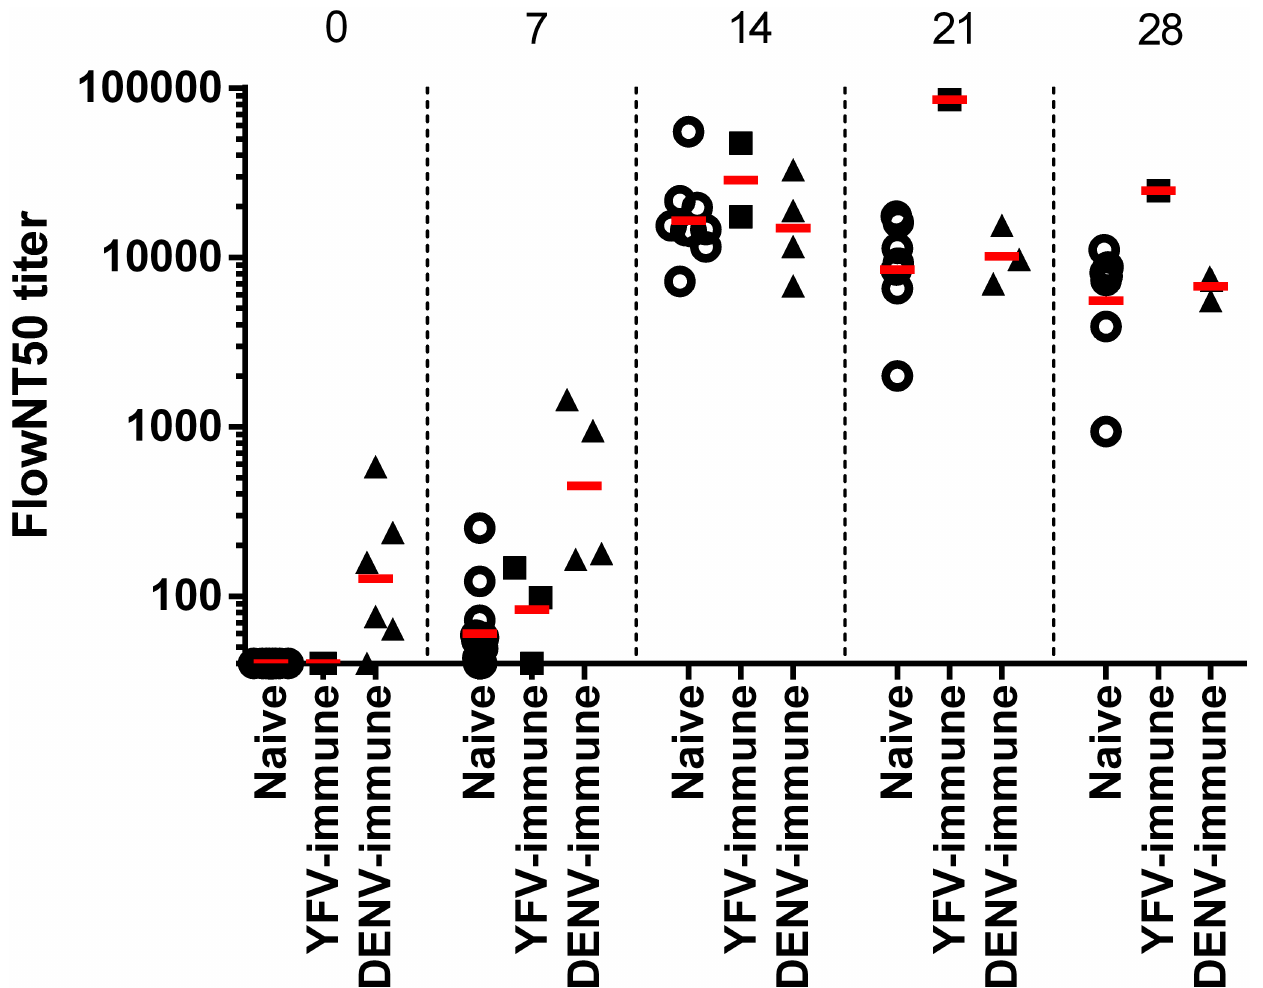
Fig 4. Kinetics of neutralizing antibody. Zika virus flow cytometry-based assay 50% neutralization (FlowNT50) titers were determined on days 0, 7, 14, 21, and 28 post-infection. The FlowNT50 titers for individualanimalswithin each group are shown with the geometric mean titer (GMT) indicatedwith a red bar. The respectivesample sizes (n) for na ï ve,YFV-immune, and DENV-immune groups were 14, 5, and 6 on day 0; 12, 3, and 4 on day 7; 9, 2, and 4 on day 14; 7, 1, and 3 on day 21; 7, 1, and 3 on day 28. The GMTs for all groupsbegin to rise on day 7, peak to a similar level on day 14 and remain high out to day 28. The single YFV-immune animal remaining on day 21 and 28 of the study demonstrated a moderatelyhigherFlowNT50 titer comparedto animalsin the na ï veand DENV-immune groups.